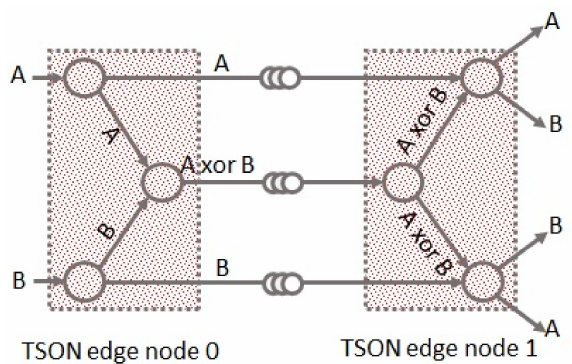
Figure 8. Butterfly network for network coding (NC) and its mapping on TSON edge